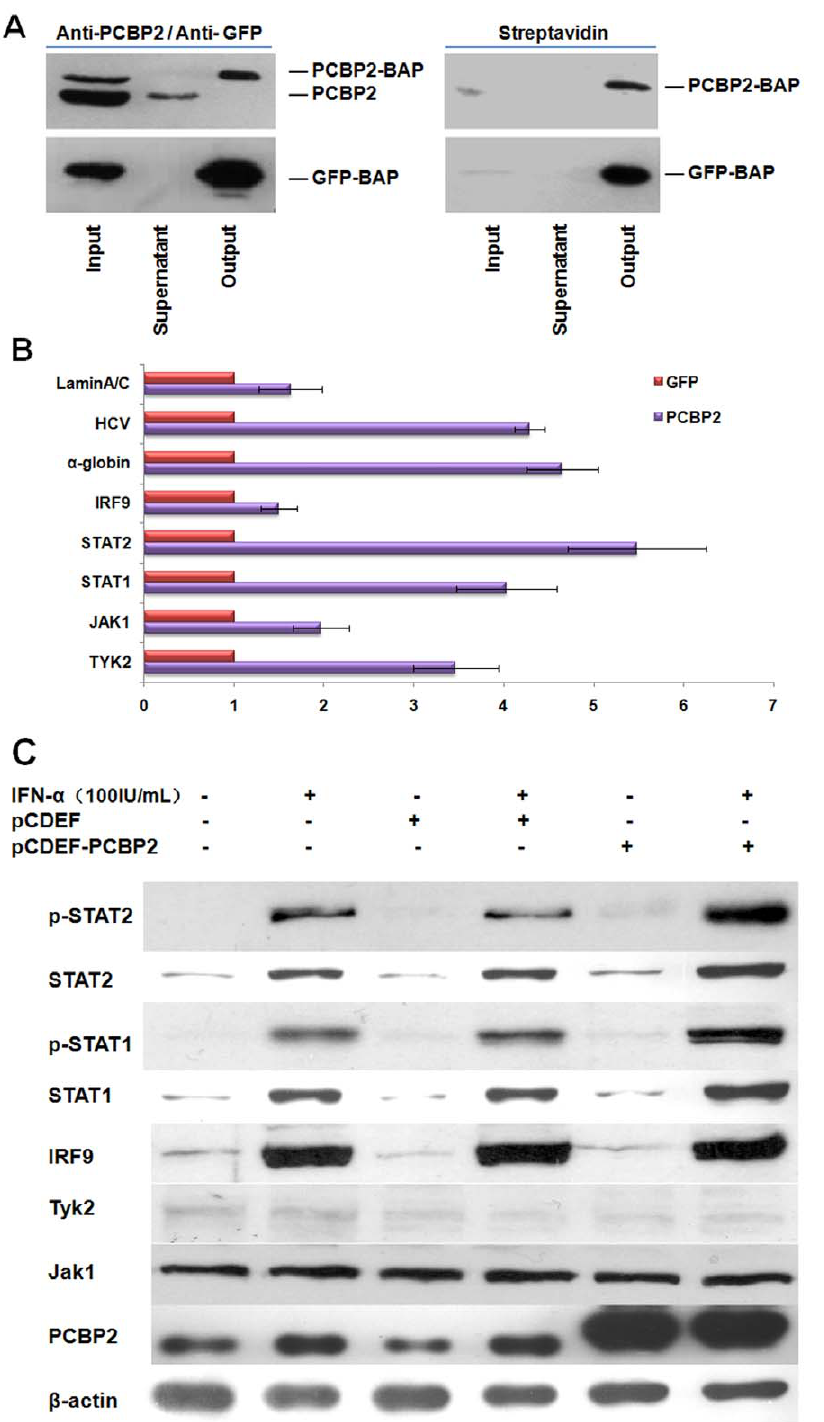
Figure 4. PCBP2 enhances the effect of IFN- a through binding STAT1 and STAT2 mRNA and up-regulates the expression of the two signal molecules in IFN- a pathway. RIP assay and targeted qRT-PCR confirmed the enrichment of different IFN- a signal pathway factor mRNAs in the PCBP2-RNA complex. (A) Detection of the PCBP2-RNA complex precipitated with streptavidin beads using anti-PCBP2 or anti-GFP antibody and streptavidin by Western blotting. (B) Targeted qRT-PCR was carried out on RNA isolated from RNP complexes precipitated in RIP assay. Analysis of mRNAs isolated from a GFP RIP reaction was carried out in parallel as nonspecific binding. a -globin was used as positive control. The enrichment of each mRNA was compared to the GFP control. Each bar represents the average of triplicate data points with standard deviation represented as the error bar . (C) PCBP2 up-regulated the expression of STAT1 and STAT2 after the treatment of IFN- a while other factors remained intact. The R1b cells were transfected with pcDEF vector or pcDEF-PCBP2. Forty-eight hours after transfection, the cells were treated with 100 IU/mL IFN- a and paired with untrasfected cells. Next, 6 hours later, the cell lysates were assessed by Western blotting.